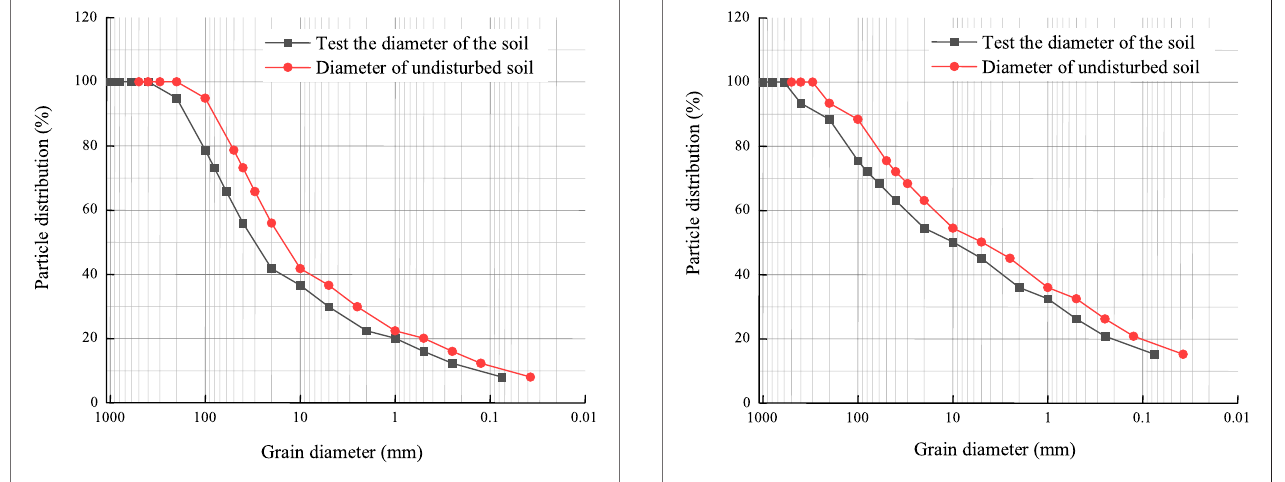
FIGURE 3 | Gradation curve of slag-soil mixture